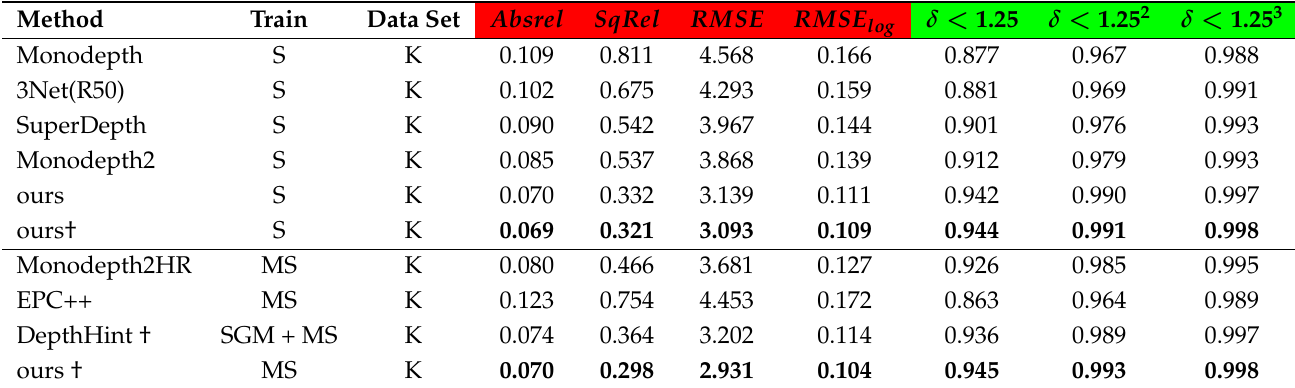
Table 2. Comparison of performance on the improved KITII Eigen Split. The best results are indicated in bold. S, trained on stereo pairs; MS, trained on calibrated binocular videos; †, using post processing steps. The metric in red is better. The metric in green is